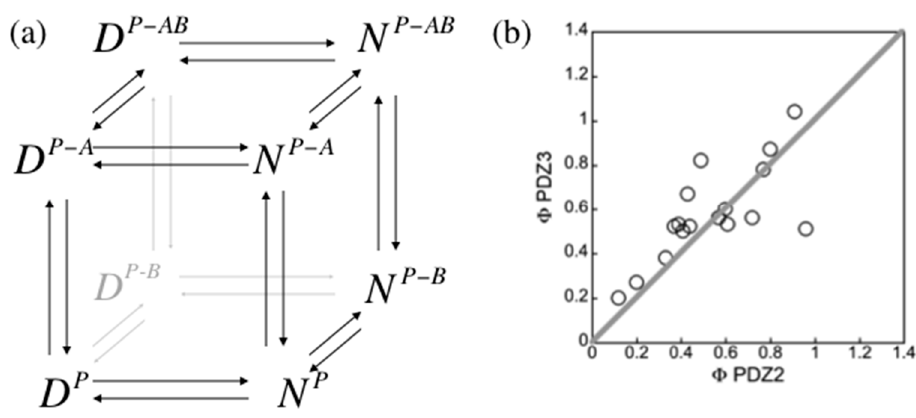
Figure 4. Additional tests for the Φ value analysis. ( a ) exemplifies an energy diagram summarizing the double mutant cycle approach. In analogy to classical protein folding, the reactant and product are referred to as the D (denatured) and N (native) states respectively. Analogously, in binding, these could represent the free and bound state. ( b ) Φ − Φ plot of two homologous PDZ domains (data from [61]). The correlation between the observed values is a signature of conservation of the folding mechanism and provides per se an additional validation of the Φ value analysis.